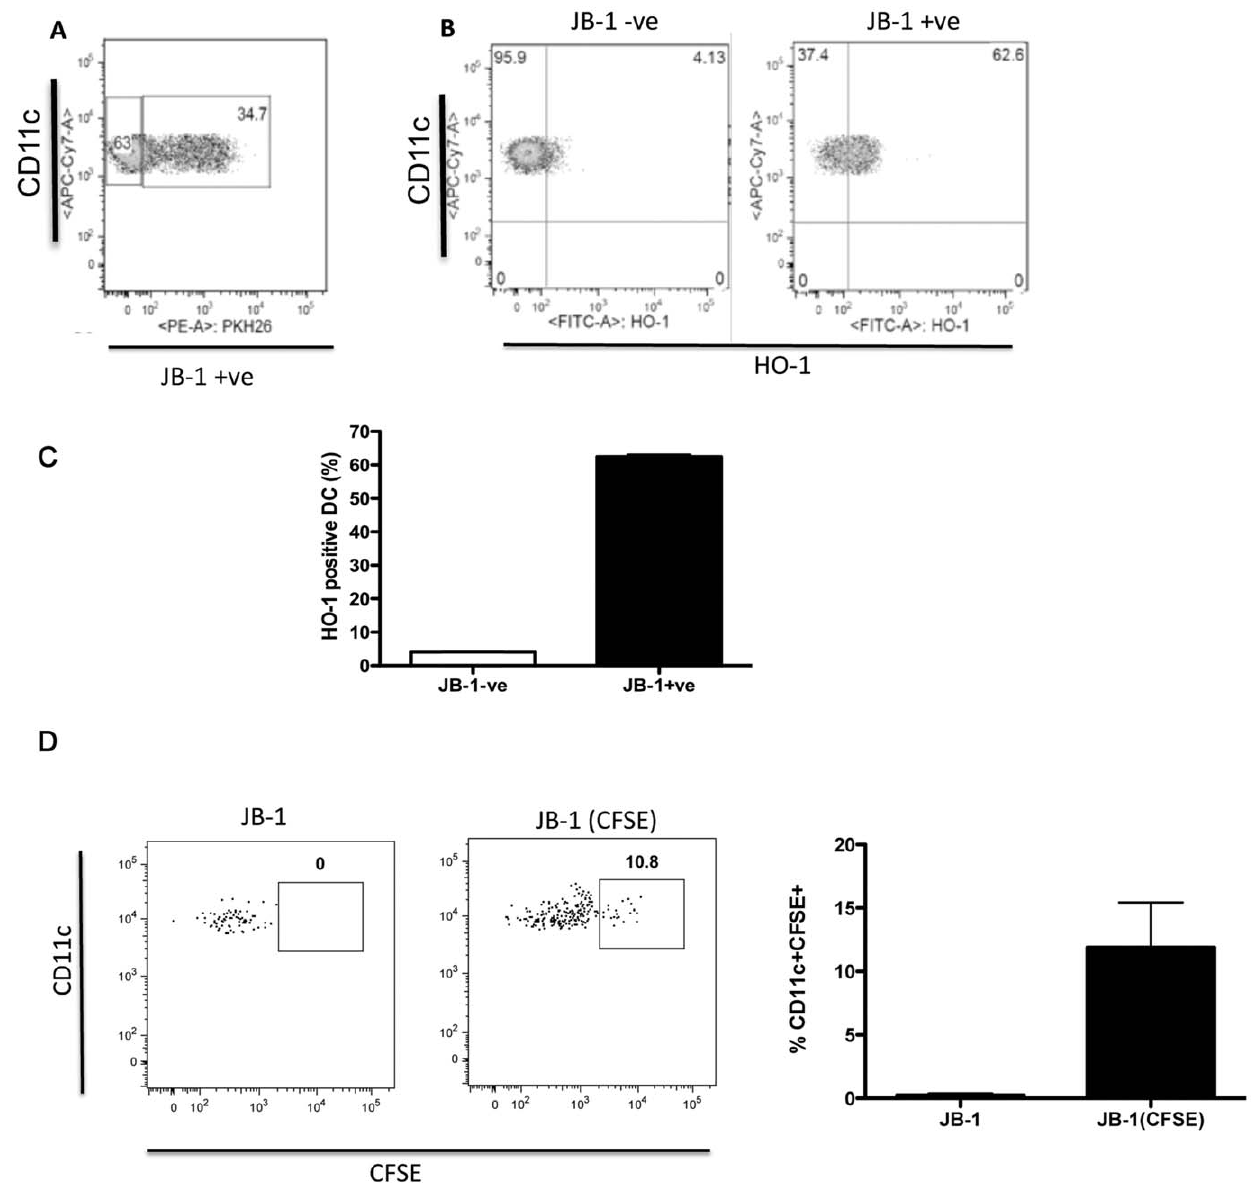
Figure 5. HO-1 expression is enhanced in Dendritic cells assocaited with JB-1. Dendritic cells were cultured from bone marrow and CD11c + cells isolated and cocultured with PKH26 labeled L.rhamnosus JB-1 for 24 hr and HO-1 expression assessed by FACS. A) A dot plot showing a subpopulation of dendritic cells associated with the labeled lactobacillus. This is representative of 4 similar experiments. B) Representative dot plots and C) mean values of the percentage HO-1 + cells in the Lactobacillus associated (JB-1 + ve) and non-associated (JB-1-ve) dendritic cell populations. Evidence for in vivo interaction between DC and JB-1 is provided by D) Representative dot plots and E) mean values of CFSE positive cells within the CD11c positive population from Peyers Patches of mice fed with CFSE labeled or unlabeled JB-1. Data presented as mean 6 SEM, n=5, *p , 0.05. CFSE=carboxyfluorescein diacetate succinimidyl ester.